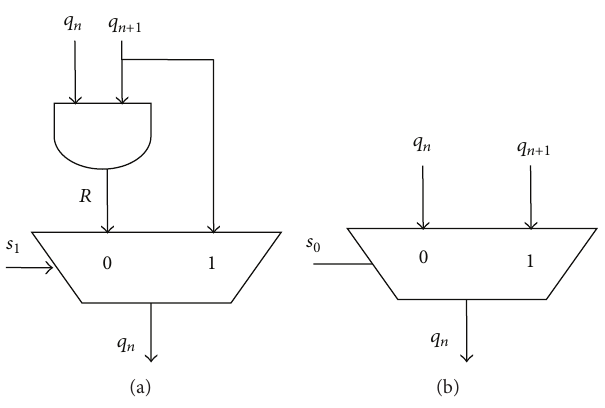
Figure 6: (a) Bit selector circuit, LSB. (b) Bit selector circuit, MSB.